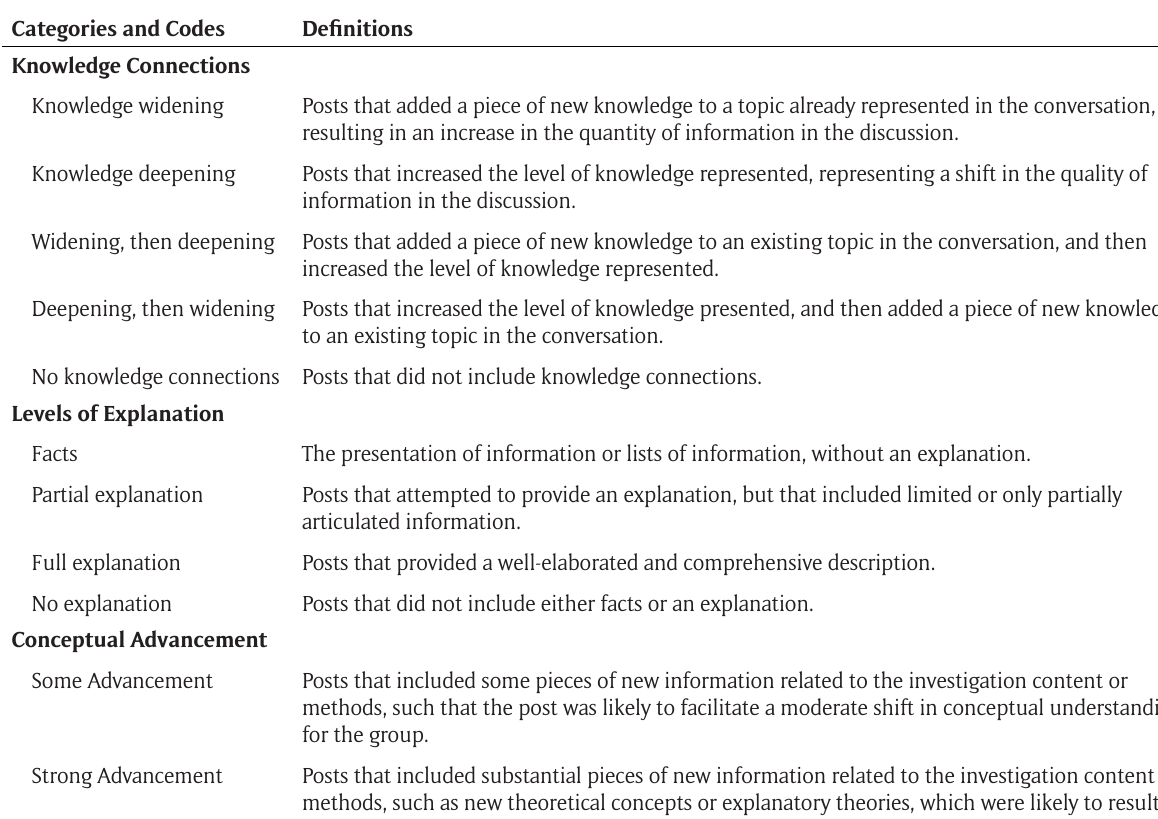
Table 1: Knowledge Building Categories and Code